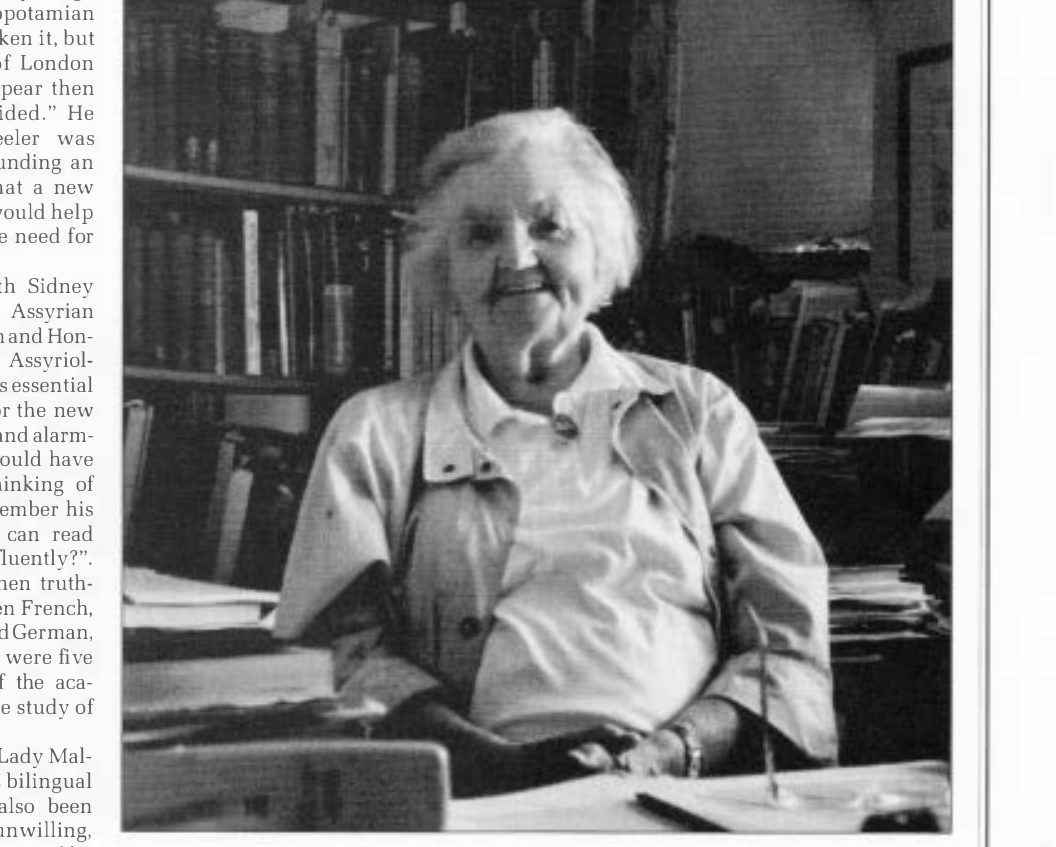
Figure 1 Rachel Maxwell-Hyslop,